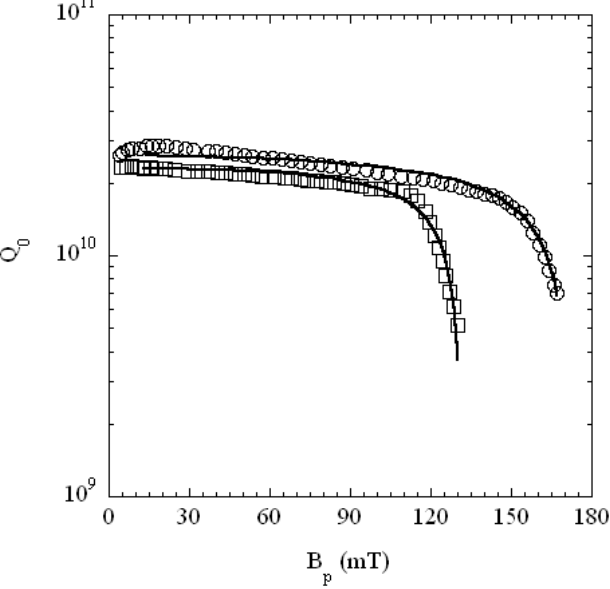
FIG. 20. Q vs B data measured after postpurification p 0 (squares) and after 120 (cid:3) C , 3 h in situ baking fitted with Eq. (7) (solid lines). The data were also shown in Fig.